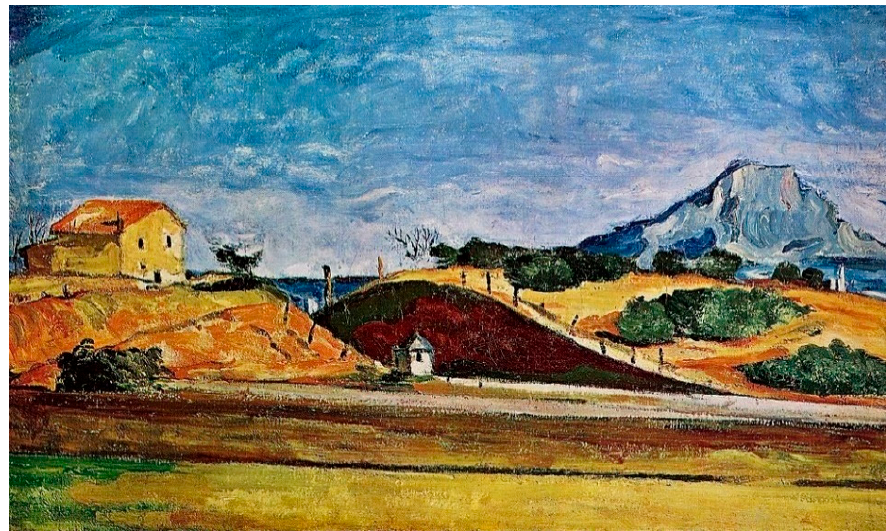
Figure 6. Paul Cezanne—Decoupage ferroviaire (1870–1871).